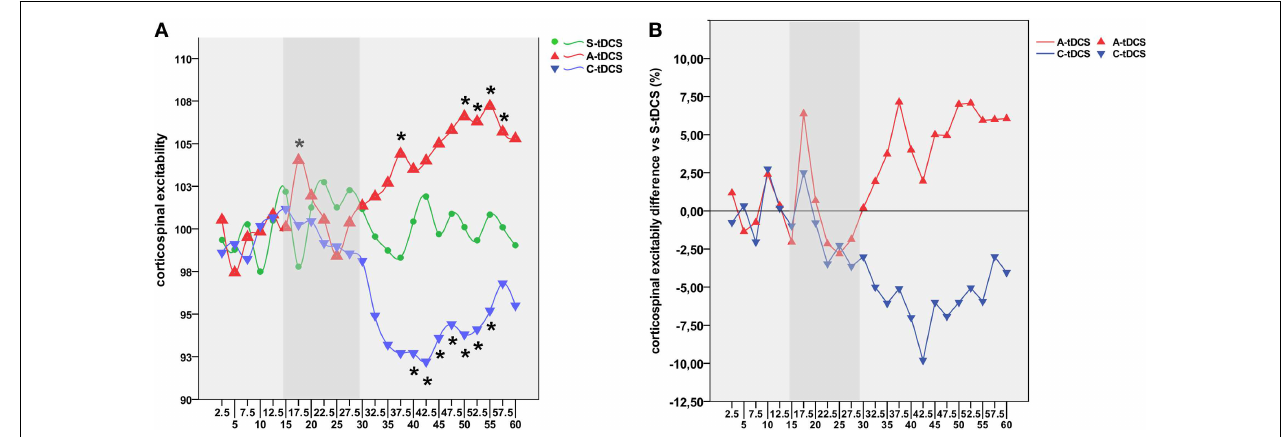
5min before the experiment for each condition. Each time point represents the average value of eight consecutive MEPs acquired within the 2.5s wide window. Asterisks indicate time points showing a significant difference with respect to S-tDCS ( p < 0.05). (B) Represents the average percentage of increase or decrease in cortical excitability for A-tDCS and C-tDCS respect with S-tDCS (straight